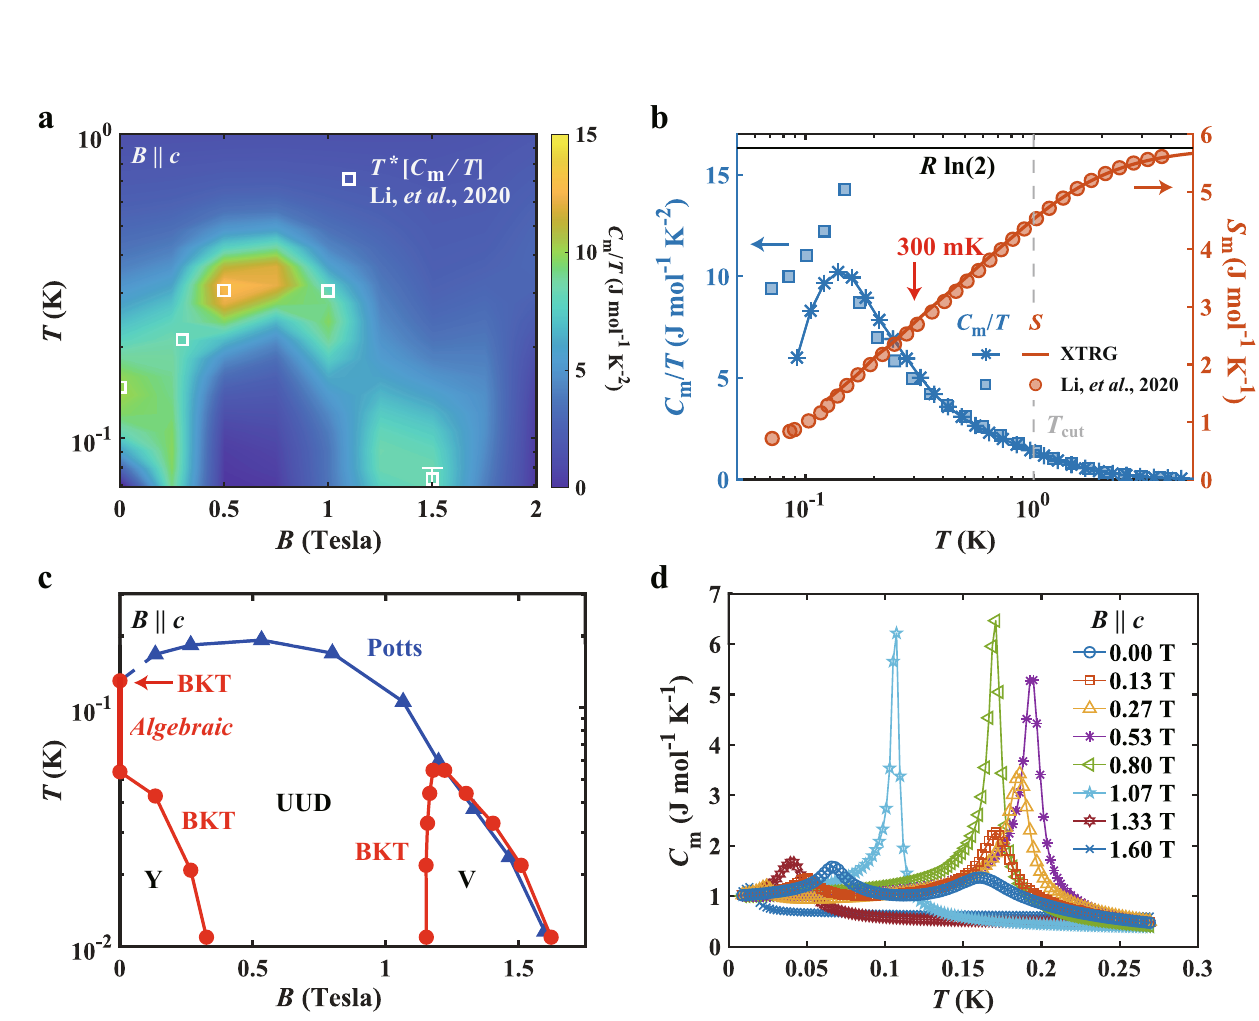
Fig. 4 Finite-temperature phase diagram of the NBCP under magnetic fi elds ∥ c . a Shows C m / T , calculated from XTRG, as a function of temperature T and magnetic fi eld ∥ c . The open squares mark the peaks of the experimental C m / T data (Li et al. 15 ). b Shows C m / T under zero fi eld, and the magnetic entropy S m , as functions of temperature. The experimental S m data are obtained by integrating numerically the C m / T data. The experimental entropy curve is shifted by 0.55 Jmol − 1 K − 1 to match the saturation value R ln ð 2 Þ at suf fi ciently high temperature. c Shows the temperature- fi eld phase diagram constructed from the classical Monte Carlo (MC) simulation. The blue triangles mark the three- state Potts transitions determined by using the Binder cumulants. Red solid circles mark the BKT transitions determined from the spin stiffness (see Methods). The zero fi eld BKT transition temperatures are reported by ref. 31 . The red solid line along the vertical axis under zero fi eld indicates the regime with algebraic spin correlation in the S z spin component. d Shows the speci fi c heat as a function of temperature for various representative magnetic fi eld ∥ c , obtained from the classical MC